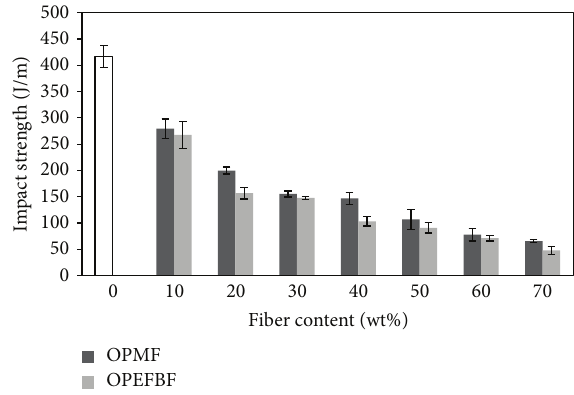
Figure 4: Impact strength of PBS, PBS/OPMF, and PBS/OPEFBF